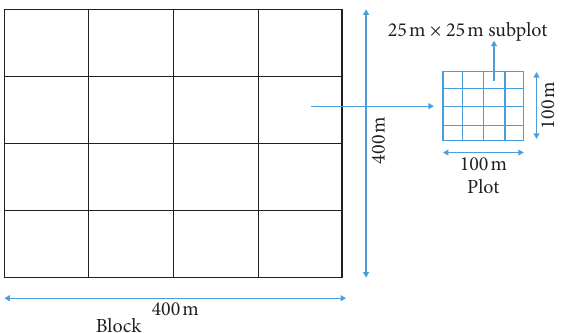
Figure 2: Sampling design for population assessment of P. falcatus in Dodola